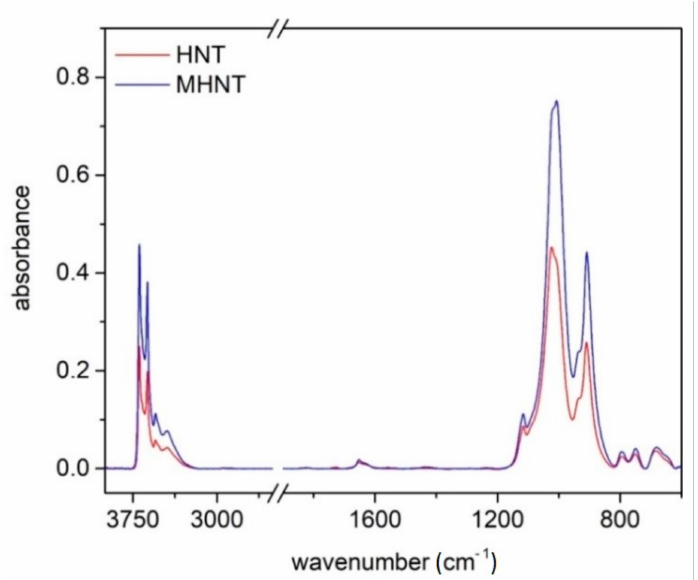
Figure 2. FTIR spectra of HNT and MHNT